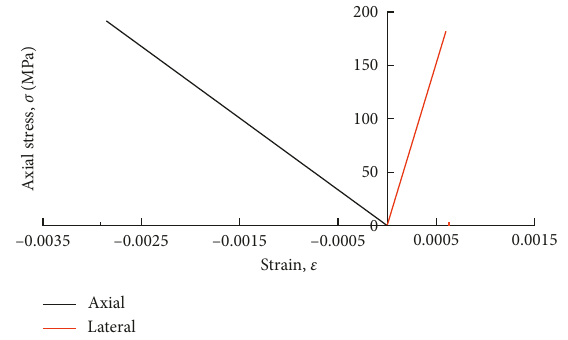
Figure 4: Axial stress-axial strain and axial stress-lateral strain curves obtained from UCS testing of the calibrated FDEM model. Recording of stress-strain results ceased once the peak strength was achieved, as the UCS numerical model is used only for the cali- bration of the elastic parameters of the